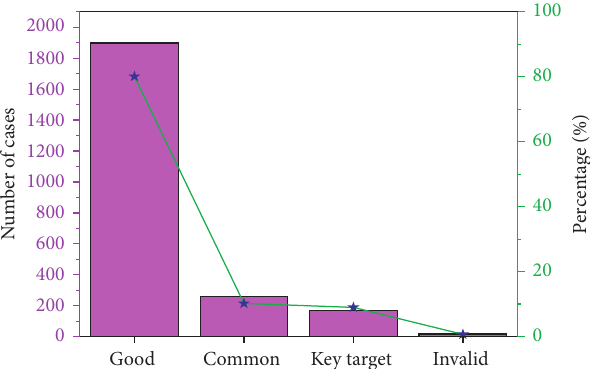
Figure 8: Statistical analysis of college students’ psychological questionnaire.